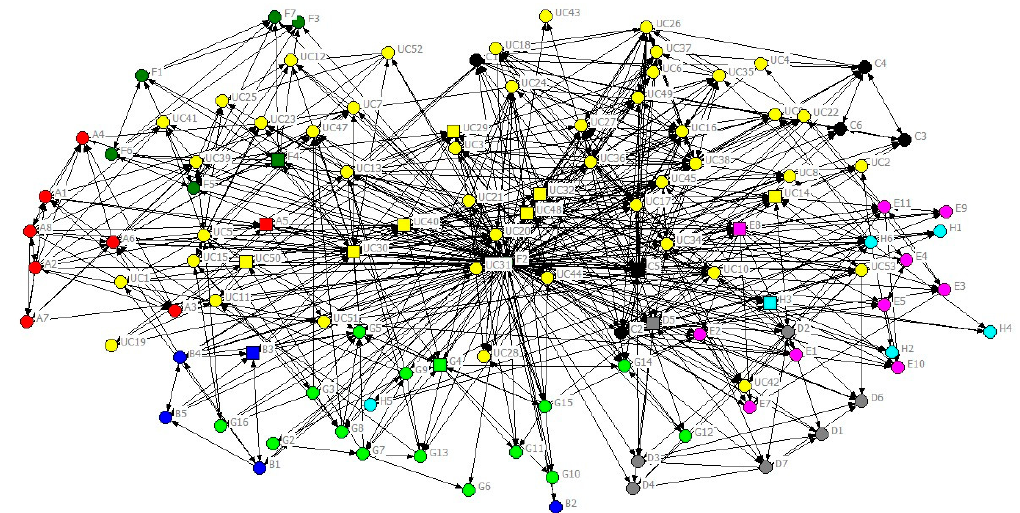
Figure 5. Phase 2 sociogram for preferred idea sharing (strength of tie = 3; organisation and seniority attribute display). *Same organisation and key contact attribute display in Figure 2.